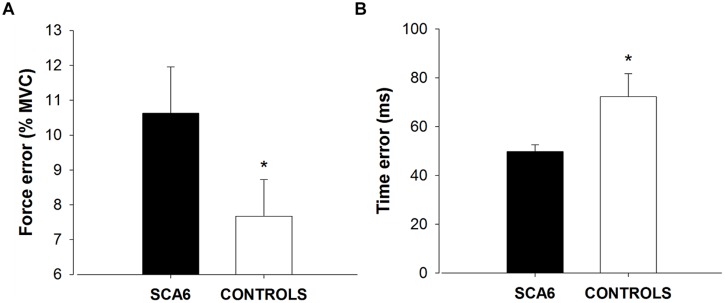
Force and time dysmetria. SCA6 participants exhibited significantly greater force error (force dysmetria; A) and lower time error (B) compared with healthy controls. * Indicates significant difference (P < 0.05) in force and time error between SCA6 and controls.